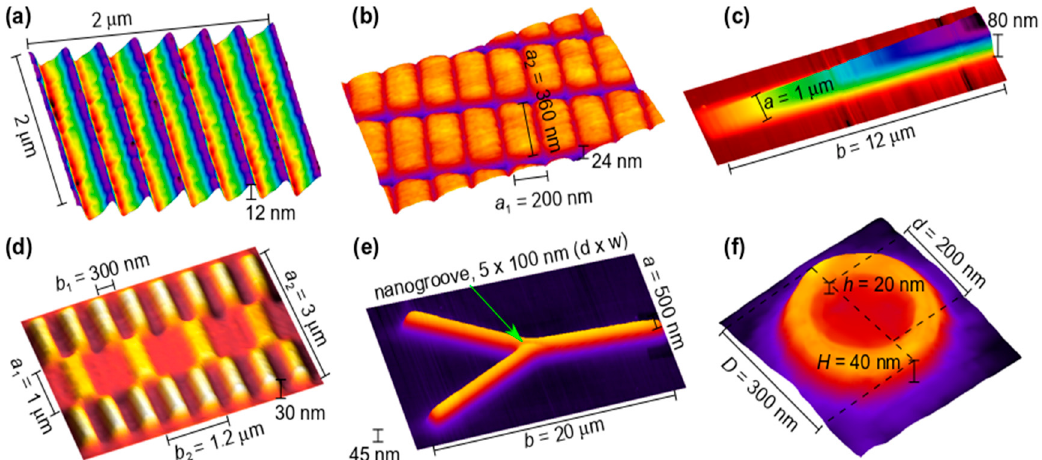
Figure 9. Atomic force microscopy images of exemplary FEBID structures for fluxonics and magnonics. ( a ) Nb film decorated with an array of asymmetrically shaped Co nanostripes inducing a ratchet pinning potential landscape of the washboard type for Abrikosov vortices. ( b ) Bi-periodic magnonic crystal on the surface of a Py film that allows for reprogramming the band structure in the magnon frequency spectrum. ( c ) Magnonic waveguide with a gradually decreasing thickness that induces a graded refractive index for spin waves via the magnetization gradient. ( d ) 3D magnonic crystal in which the thickness modulation period is a factor of two larger than the width modulation period. ( e ) Y-shaped magnonic waveguide with a nanogroove milled by focused ion beam (FIB) at the junction for frequency-selective steering of spin waves via the refraction and reflection effects. ( f ) “Nano-volcano” for ferromagnetic resonance studies. Structures ( b – f ) are fabricated from Co 3 Fe employing the precursor HFeCo 3 (CO) 12 .